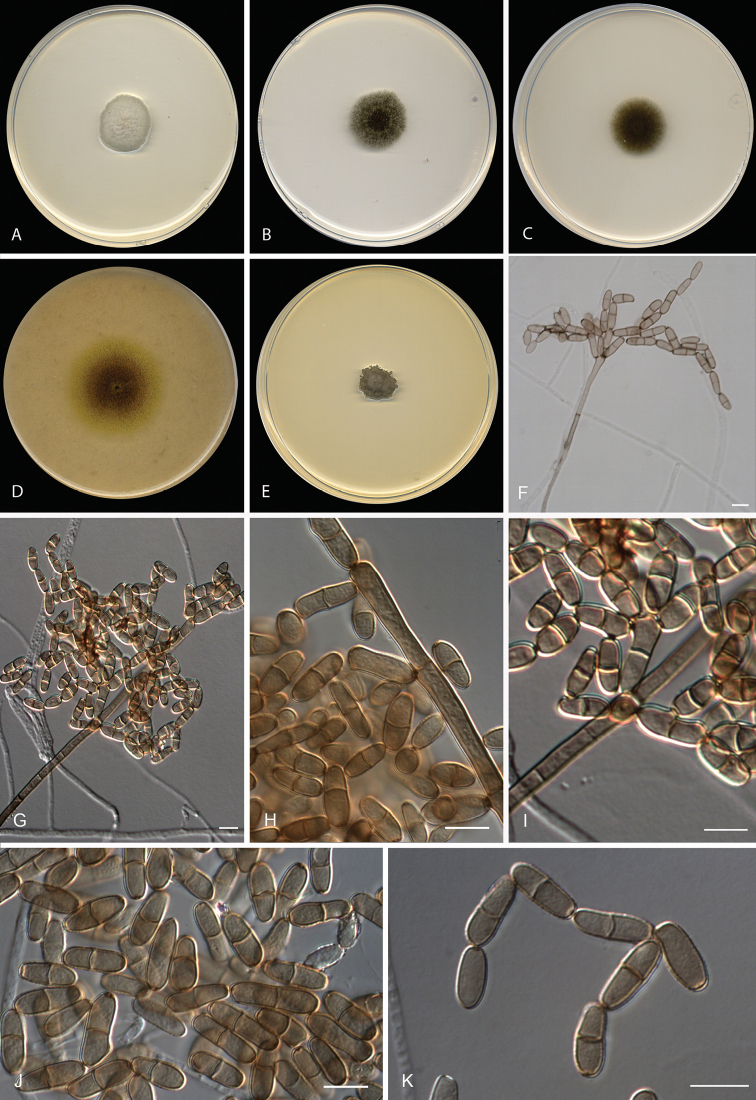
Neodendryphiellamali sp. nov. (ex-type CBS 139.95). A–E Colonies on
APDAB PCA C SNA D OA
E MEA at 25 °C after 14 d F–K Conidiophores and conidia.
Scale bars: 10 µm (F–K).